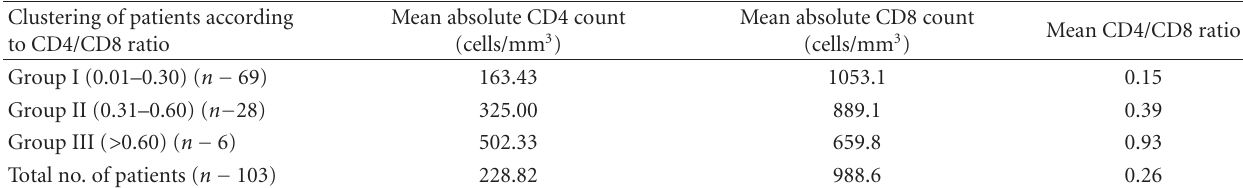
Table 2: Absolute mean CD4 and CD8 counts along with mean CD4/CD8 ratio of study cohort.